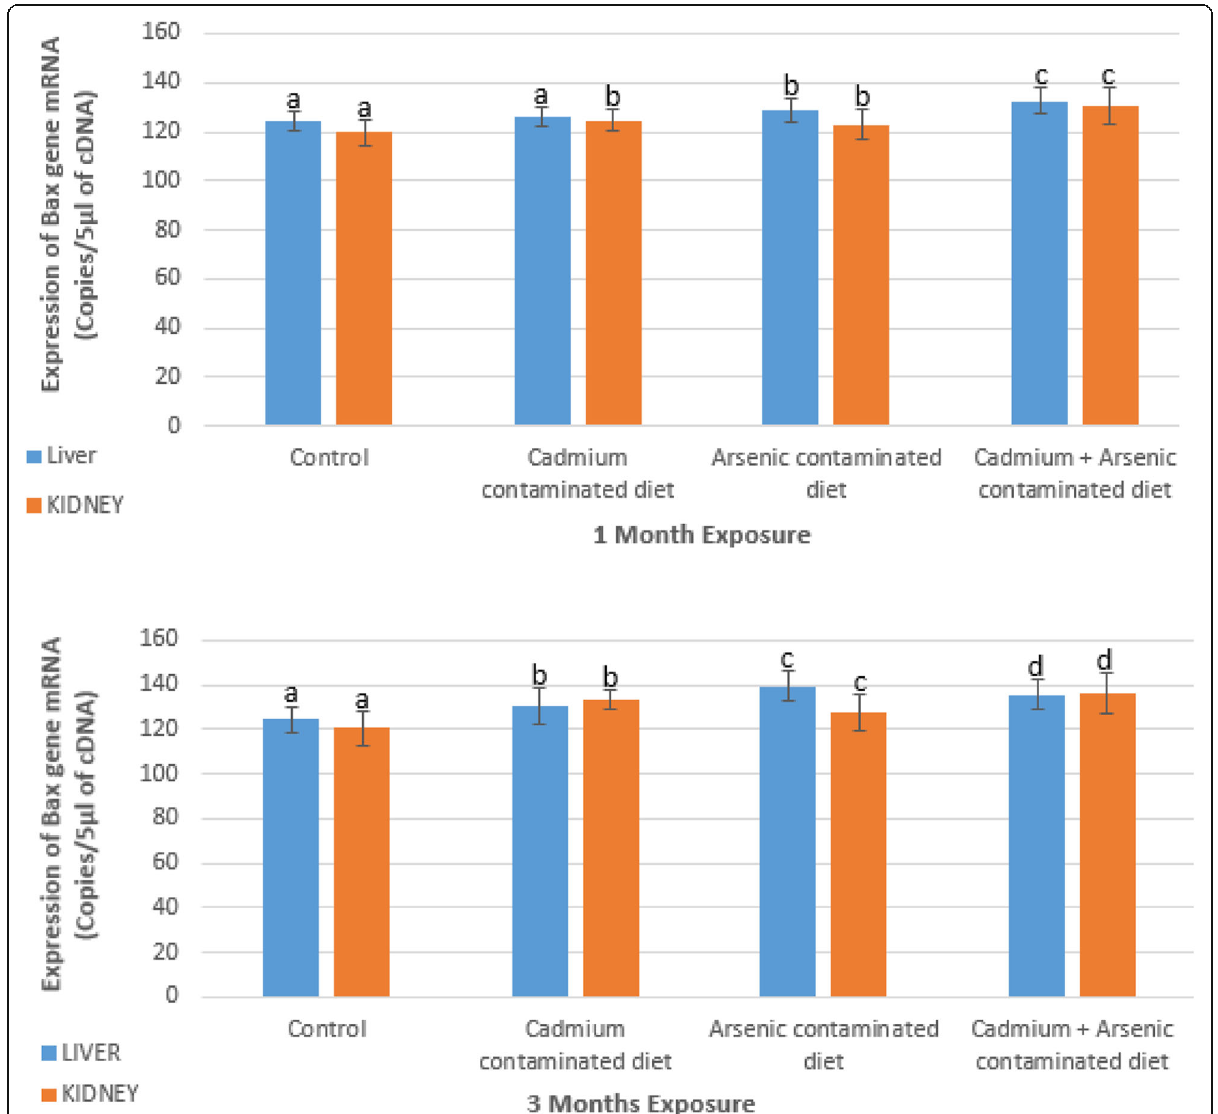
Fig. 3 Changes in the expression of Bax gene mRNA in the liver and kidney of rats after 1- and 3-month exposures to experimental diet. Values not sharing the same superscript within a tissue differ significantly at P <